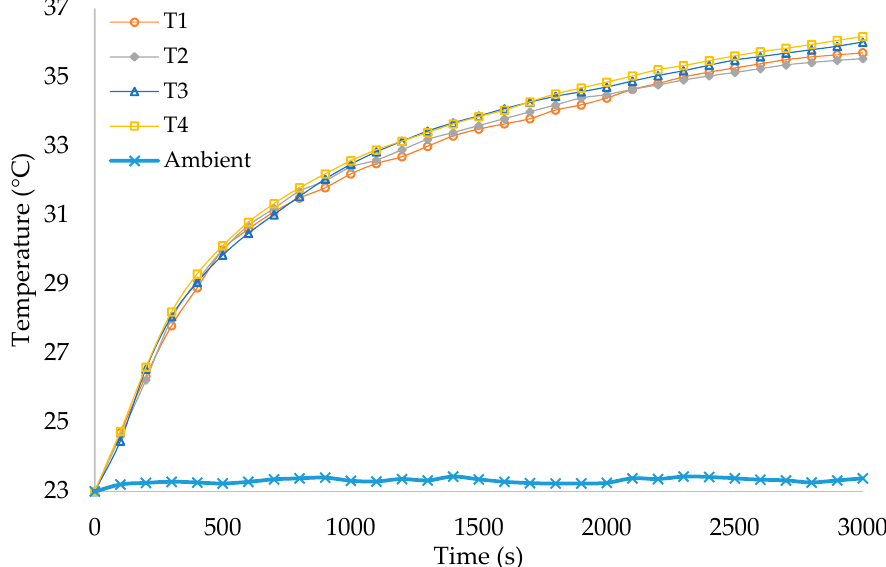
Figure 5. The temperature of the LiC cells within the module after cooling down by the HPA-TMS.